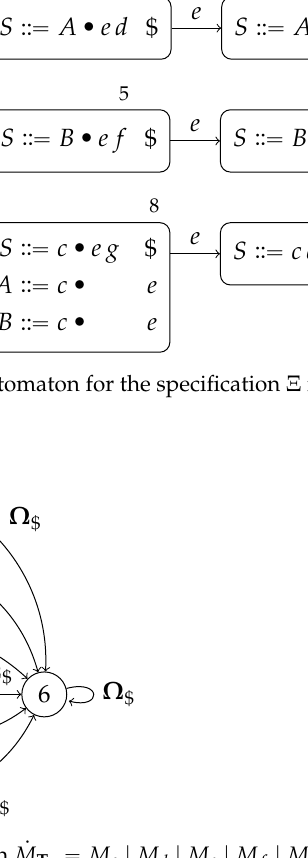
“ M c | M d | M e | M f | M g | M $ for the specification Ξ in $